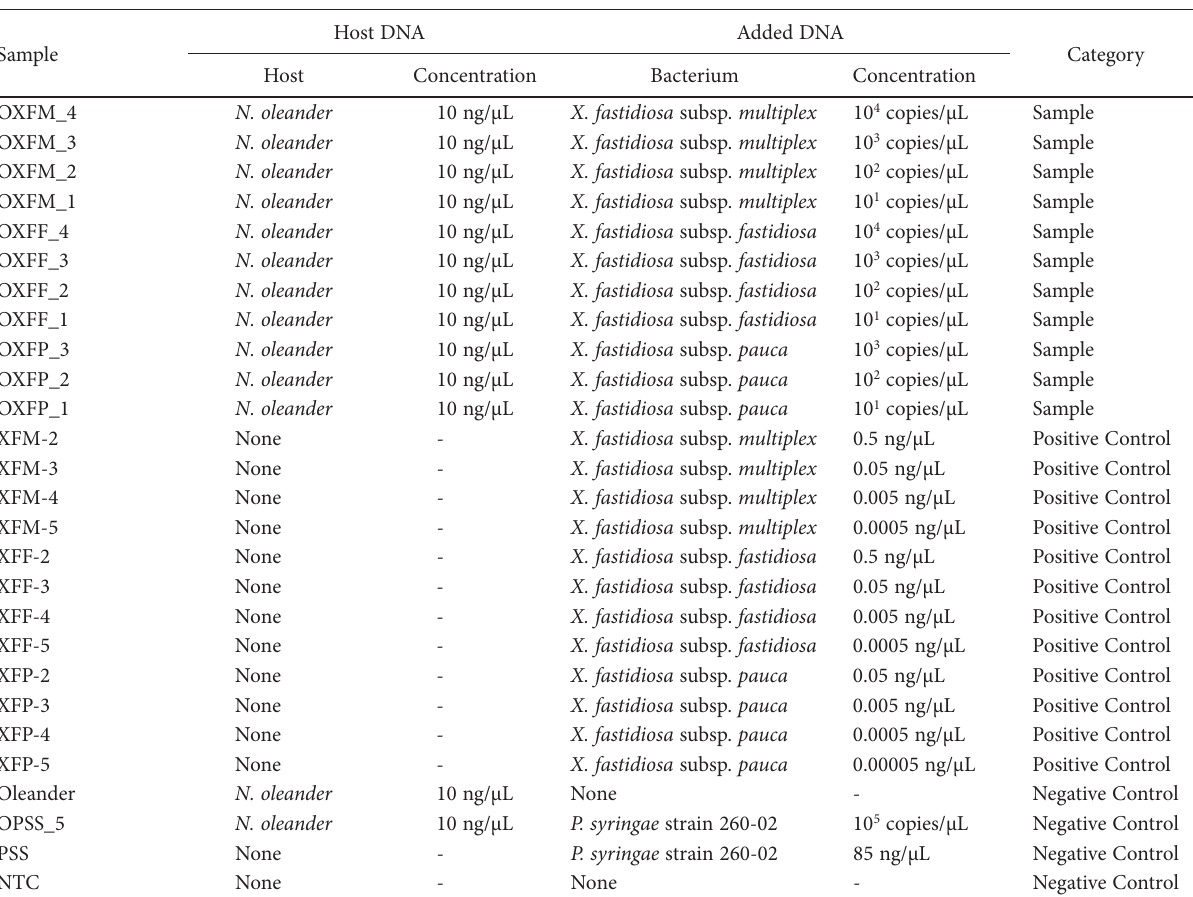
Table 1. List of samples, positive controls, and negative controls included in the first set of analyzed material. The table reports for each sample/control the name, composition of host DNA and the source of added DNA. The concentration of the nucleic acids is expressed either as ng µL -1 or copy number per µL, depending on which parameter was more relevant during the preparation of the sample. This concentration value is an approximation used to express the order of magnitude of the target (for copies per µL) or rounded to the nearest multiple of 5 (for ng µL -1